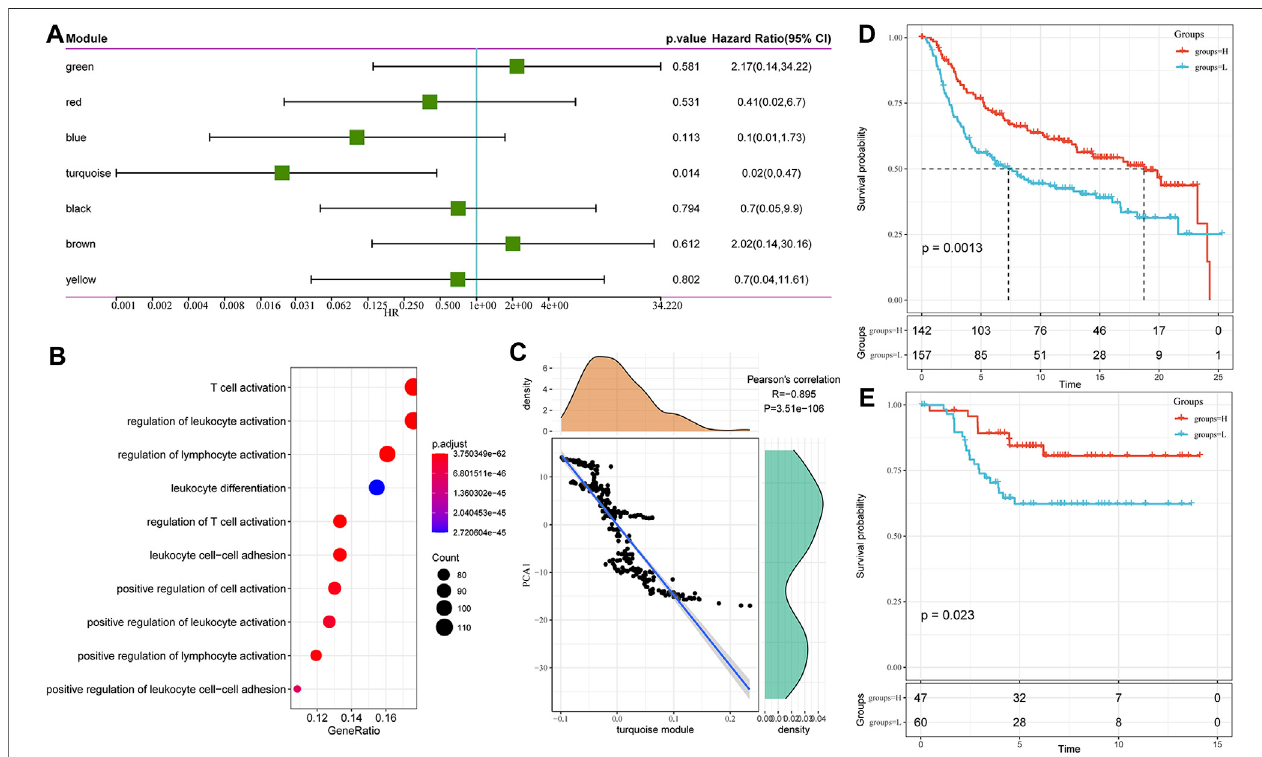
FIGURE 8 | (A) Univariate analysis results of gene module eigengenes. (B) Gene enrichment analysis of the turquoise module. (C) Correlation between the turquoise module eigengene and the fi rstprincipal componentinthe immune landscape. (D) KM survivalcurve distribution ofpatients grouped inthe METABRIC-TNBC cohort according to the expression of model characteristic genes screened from the turquoise module. (E) KM survival curve distribution of patients grouped in the GSE58812 cohort according to the expression of model characteristic genes screened from the turquoise